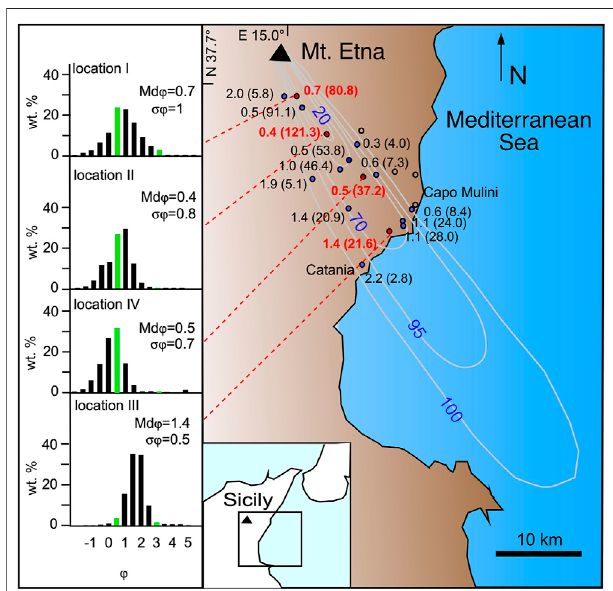
FIGURE1| Isomassmapofthetephrafalldepositformedbythe21May 2016 Etna paroxysm, with inset location on Sicily (bottom left). Blue numbers ontheisolinesrepresentthepercentageofdepositmassenclosed.Bluedots: samplinglocations.Numbersindicatemediangrainsize(inphi)andmass load in brackets (in g/m 2 ). Red dots: location where the deposit was sampled for ash characterisation. Light green bars in histograms of grainsize distributions:grainsizefractionsanalysedforshapecharacteristics.Datafrom Edwards et al. (2018).